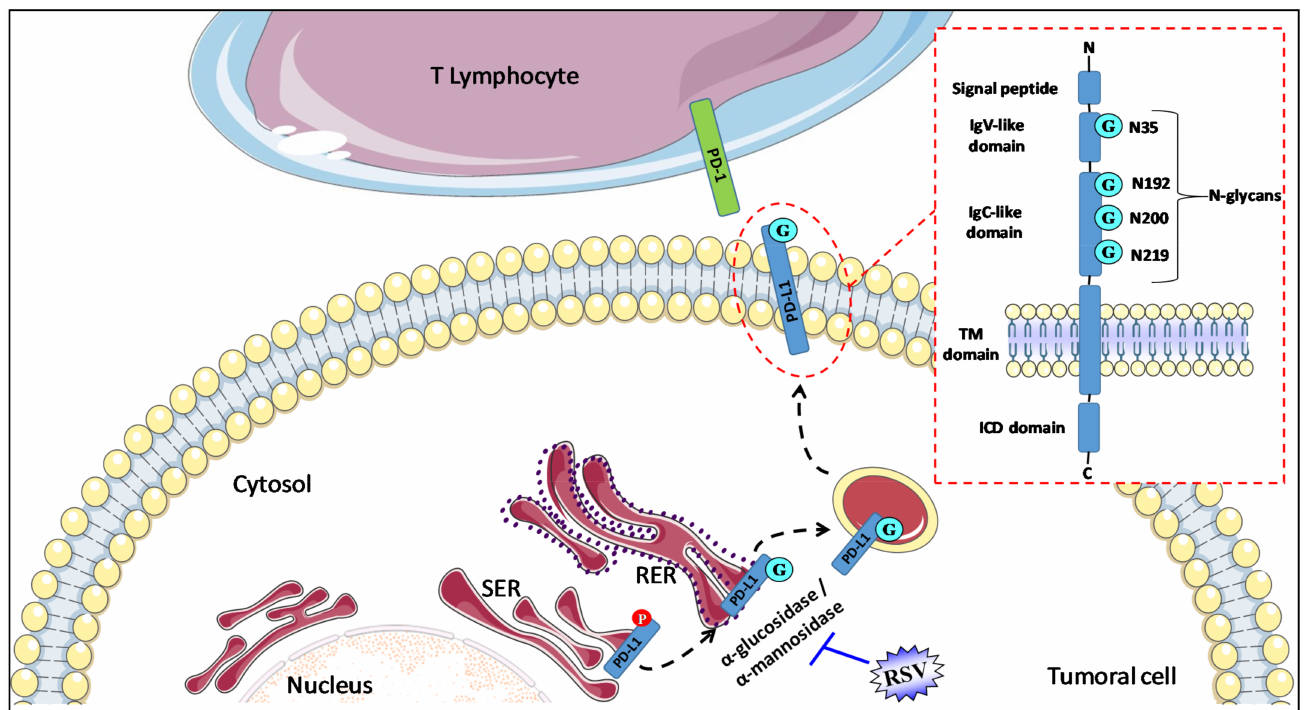
Figure 1. RSV alters N-glycosylation to disrupt PD-1/PD-L1 interaction. PD-L1 is composed of a transmembrane region (TM domain) and two extracellular domains, the IgC-like and IgV-like domains. The short intracytoplasmic domain (ICD domain) of PD-L1 is responsible for the triggering of the signaling pathways inside cells. N-glycosylation is a major post-translational modification of PD-L1 that is crucial for its stability (prevention of PD-L1 degradation through GSK- 3 β -mediated 26S proteasome), intracellular trafficking, and functions (protein–protein interactions). Four glycosylation sites of asparagine residues (G) span within the IgV-like (1 site, N35) and IgC-like domains (3 sites of glycosylation, N192, N200, and N219). There is a ≈ 17 kDa shift in PD-L1 molecular weight between its non- (33 kDa) and N-glycosylated form (50 kDa). RSV interacts with and blocks α -glucosidase/ α -mannosidase in tumoral cells and prevents glyco-PD-L1- processing, which, in turn, promotes the retention of the abnormally glycosylated form of PD-L1 in the endoplasmic reticulum. Ig-V, immunoglobulin variable; IgC, immunoglobulin constant; SER, smooth endoplasmic reticulum; RER, rough endoplasmic reticulum; TM, transmembrane; ICD, intracellular